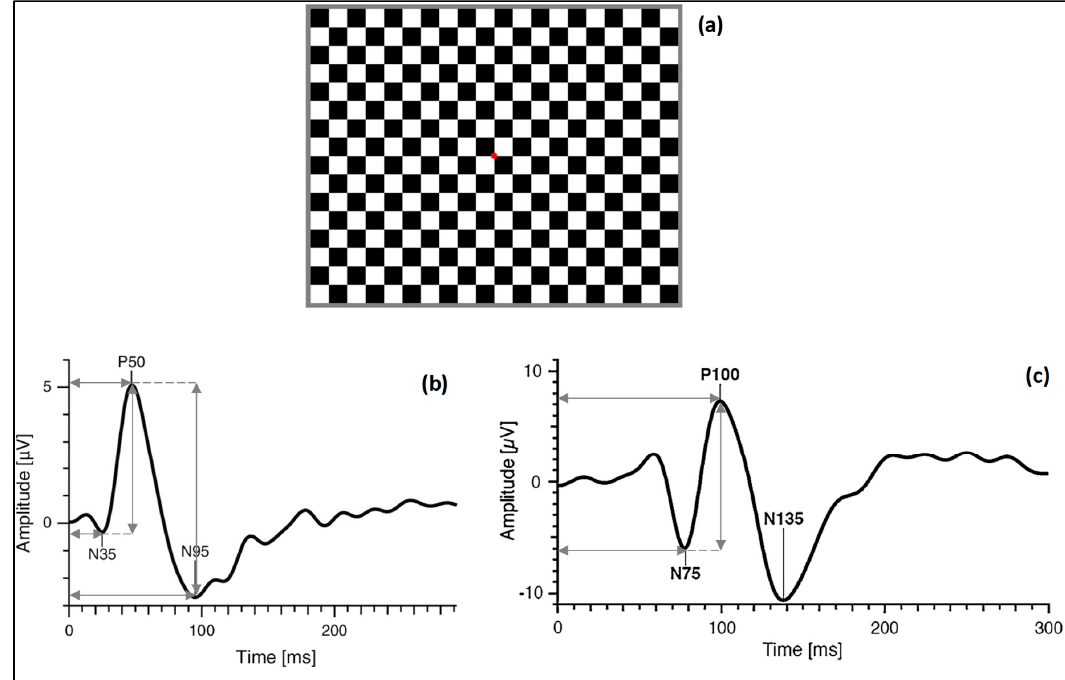
Figure 1. ( a ) Checkerboard pattern with red fixation point; ( b ) typical waveform of pattern electroretinography (PERG), horizontal arrows indicate implicit time of N35, P50 and N95 (ms) and vertical arrows indicate amplitude values of P50 and N95; ( c ) typical waveform of visual evoked potential (VEP), horizontal arrows indicate implicit time of N75 and P100 (ms) and vertical arrow indicates amplitude of